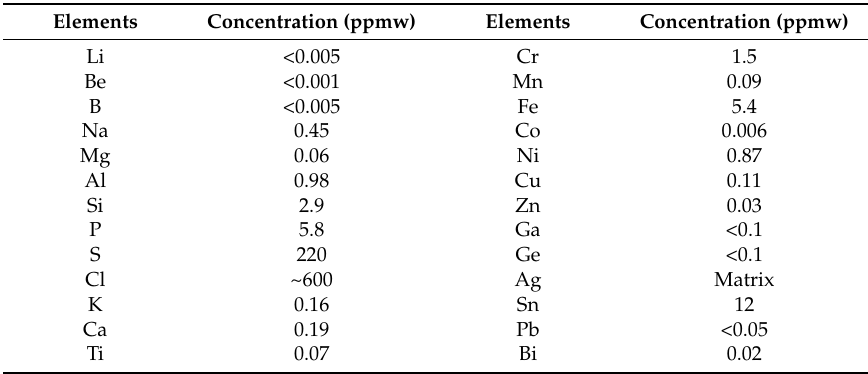
Table 2. Purity of the as-recovered Ag